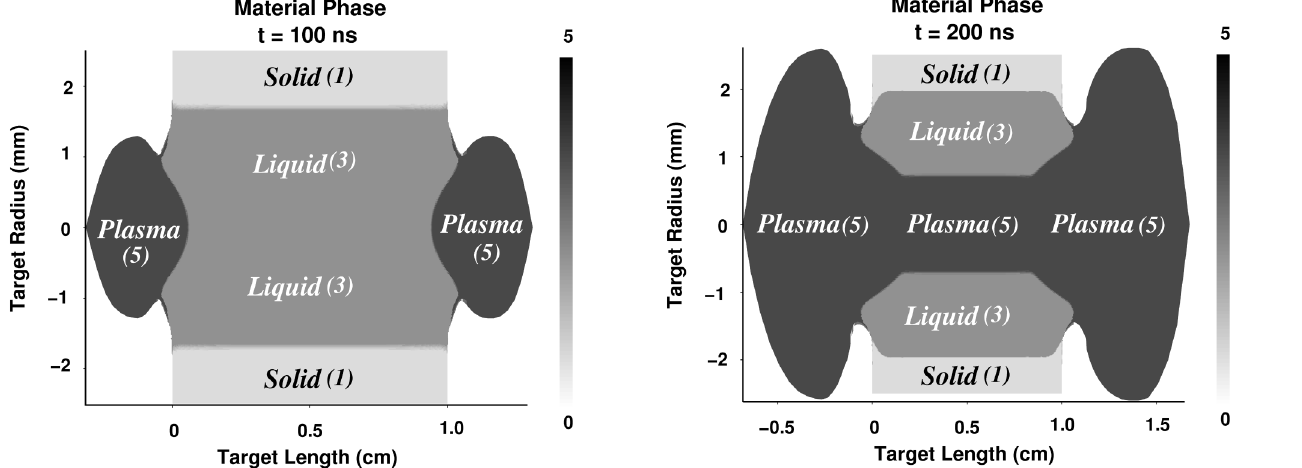
FIG. 13. Matter state at t (cid:3) 100 ns corresponding to the case shown in Fig.5.